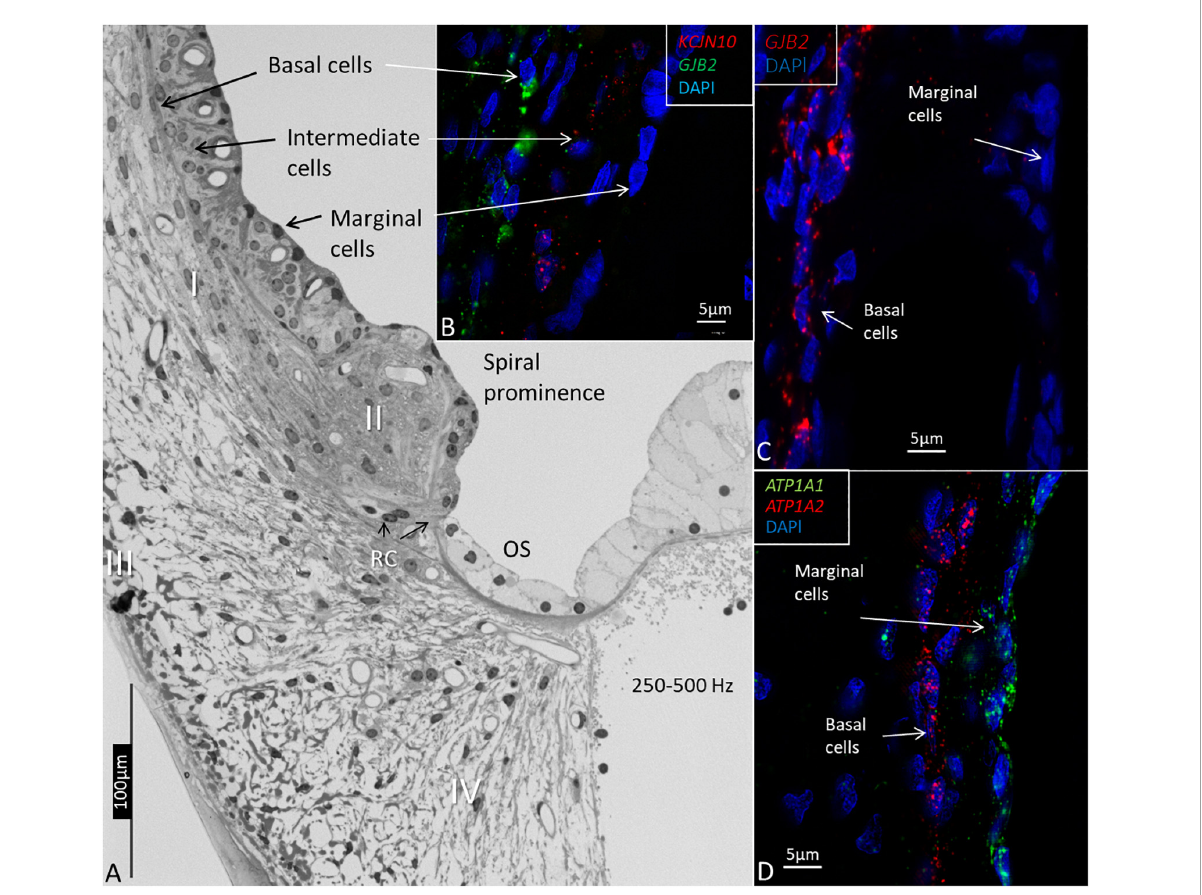
FIGURE3 Light microscopy and confocal microscopy of the lateral wall of the upper-middle cochlear turn (frequency location 250–500Hz) showing marginal, intermediate, and basal cells of the stria vascularis. (A) The marginal cells are believed to be true epithelial cells, but there is no continuous basal lamina. Type I fibrocytes (I) of the spiral ligament lie close to the basal cells. The spiral prominence epithelium is flatter and is related to the type II fibrocytes. The outer sulcus (OS) epithelium, and Claudius and Hensen cells have a light cytoplasm and are fairly organelle-free. Root cells (RCs) project into the subepithelial space. Type III fibrocytes are located near the bone, and type IV faces the scala tympani. (B) RNAscope shows the distribution of KCNJ10 and GJB2 gene transcripts in intermediate and basal cells. (C) GJB2 transcripts are located in the basal cells, but not in the marginal cells. (D) ATP1A1 gene transcripts are seen in the marginal cells, while the basal cells contain ATP1A2